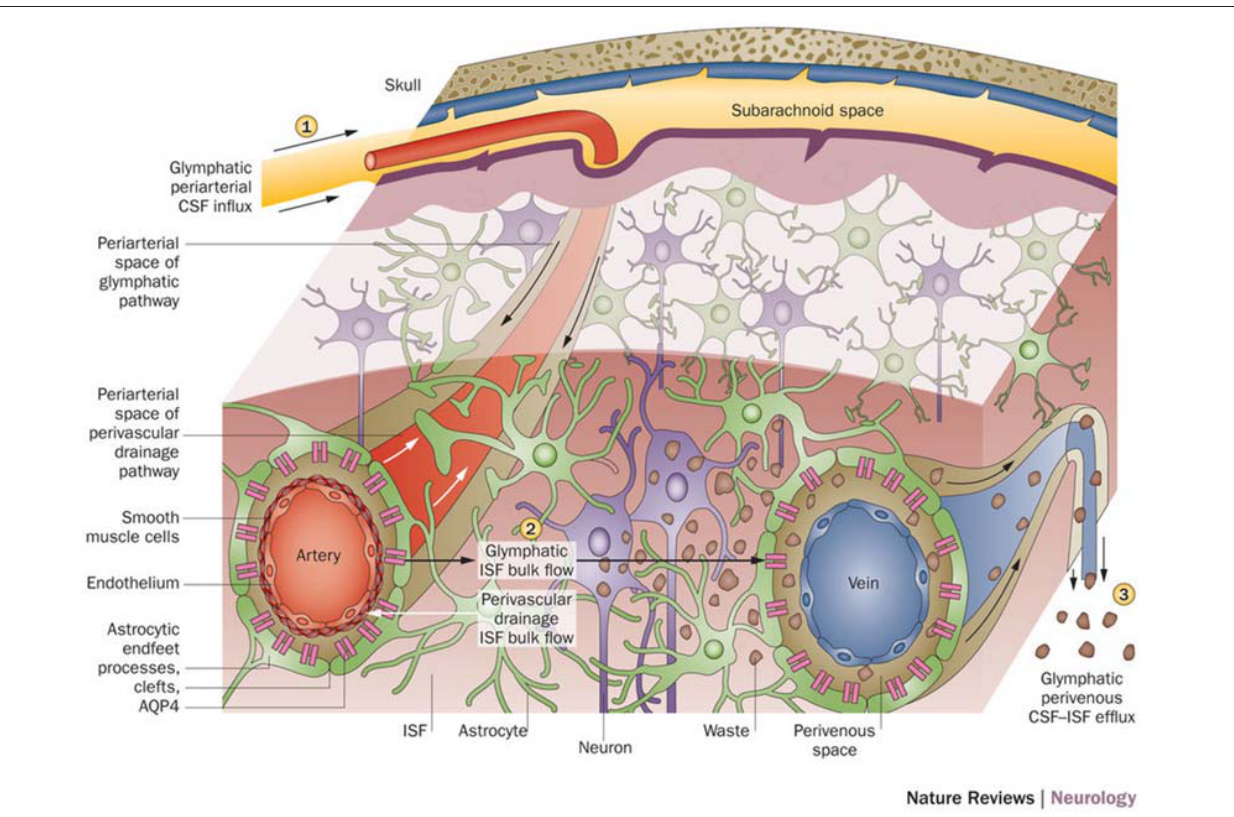
FIGURE 2 | Schematic of glymphatic and perivascular waste clearance routes. According to the glymphatic model, cerebrospinal fluid (CSF) flows along para-arterial spaces (1) , mixes with interstitial fluid (ISF) and solutes (2) , and is cleared from the brain along para-venous spaces (3) . Efficient glymphatic clearance of waste and solutes is dependent on fluid movement across aquaporin-4 (AQP4) channels located on astrocytic endfeet surrounding the parenchymal vasculature. In contrast, perivascular drainage of ISF and solutes occurs along the middle layers of the basement membrane of arterial smooth muscle cells and, as indicated by arrows, flows in a direction opposite to that of glymphatic clearance. Reprinted with permission from Macmillan Publishers Ltd: © Tarasoff-Conway et al.